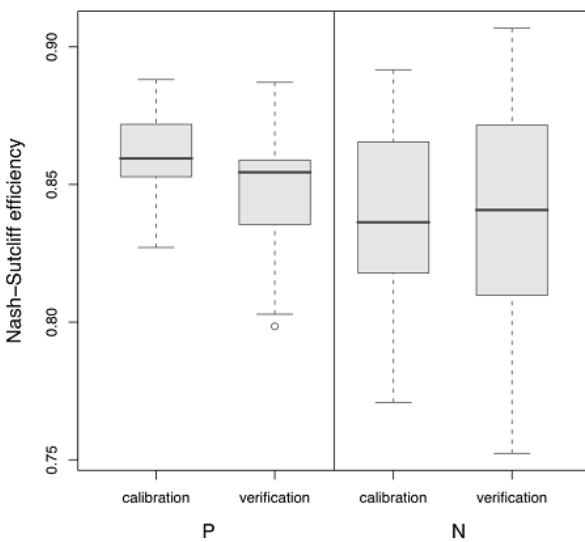
Fig. 6. Verification of R version of MONERIS for La Tordera. Cal- ibration boxplots summarize Nash-Sutcliffe efficiencies for 35 au- tomatic calibrations of the model (all combinations of four years in the period 1996–2002). Verification boxplots are for model runs with the parameter set from each calibration on the three years not used in the calibration for each of the 35 models runs.